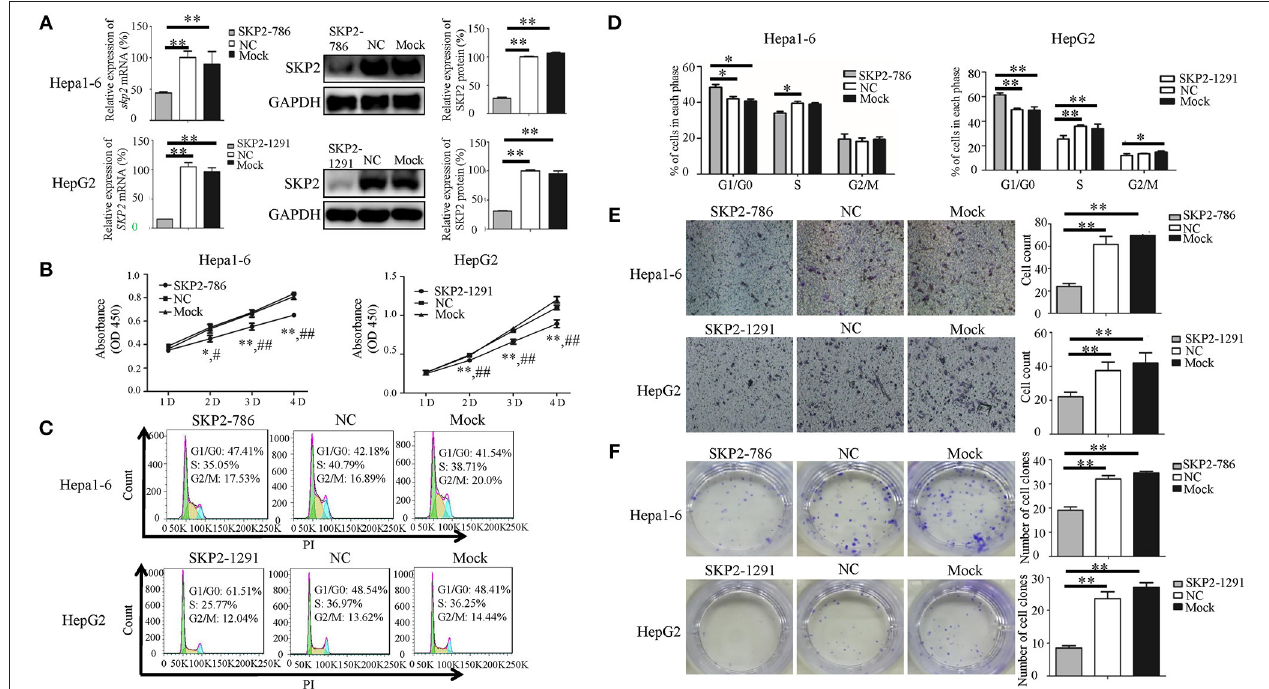
FIGURE 5 | Knockdown of SKP2 inhibits cell proliferation and migration of Hepa1-6 and HepG2 cells in vitro. (A–F) Hepa1-6 and HepG2 cells were transfected with SKP2 siRNA and negative control (NC) siRNA, respectively, and 48h later (except for the cell counting kit-8(CCK-8) assay, which was 24h later), the expression of SKP2 was determined using qRT-PCR and western blotting (A) . Cell proliferation was evaluated using the CCK-8 assay at 1, 2, 3, and 4 d (B) , data are presented as the mean ± SD, n = 3, * p < 0.05 or ** p < 0.01 indicates the comparison between the two groups of sja-miR-7-5p and NC; # p < 0.05 or ## p < 0.01 indicates the comparison between the two groups of sja-miR-7-5p and Mock. Cell cycle was determined using flow cytometry analysis (C,D) . Cell migration was evaluated by using Transwell inserts without matrigel coating (E) . The ability to form cell clones was determined using a colony formation assay (F) . Data are presented as the mean ± SD, n = 3, * p < 0.05, ** p <